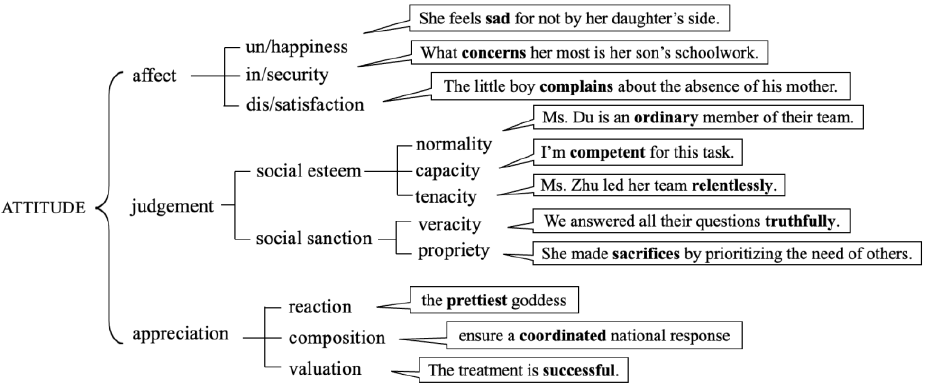
Figure 1. Basic System of ATTITUDE